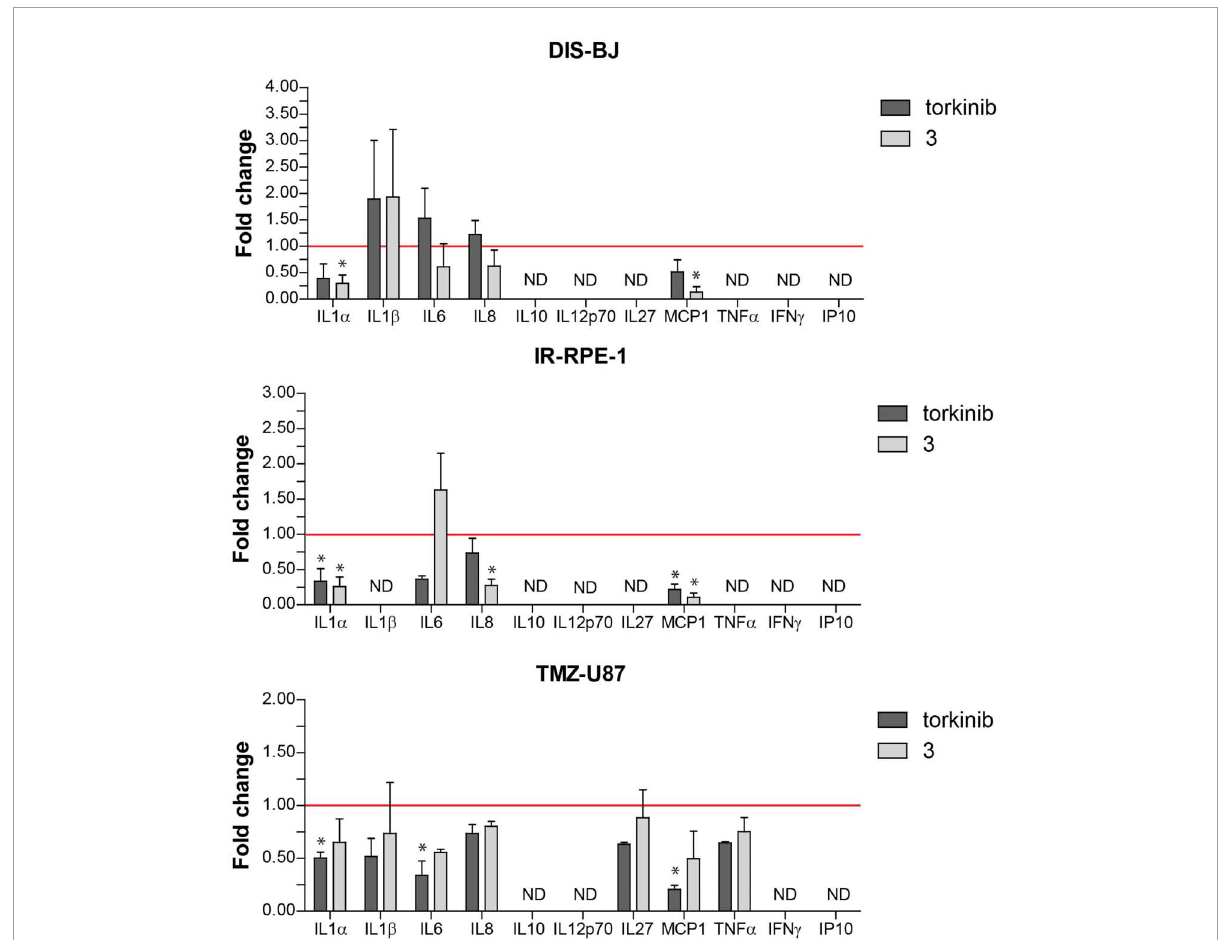
FIGURE12 Secretion of pro-inflammatory cytokines by senescent cells after exposure to compound 3 and torkinib. Determination of 11 pro-inflammatory cytokines IL-1 α , IL-1 β , IL-6, IL-8, IL-10, IL-12p70, IL-27, MCP-1, IFN γ , TNF α , and IP-10, and IP-10 in docetaxel-(DIS-BJ), ionizing-radiation- (IR-RPE-1), and temozolomide-induced (TMZ-U87) senescent cells exposed to compound 3 and torkinib (50 µ M) for 24 h. Conditioned media were collected 24 h after treatment and analyzed for the level of cytokines by FACS analysis. The experiment was done in triplicate (TMZ-U87 in duplicate). Data were normalized to untreated cells as fold induction to control (set as 1, red line) and plotted as mean ± SEM. ND, not detected. Two-tailed Student’s t -test, ∗ p <